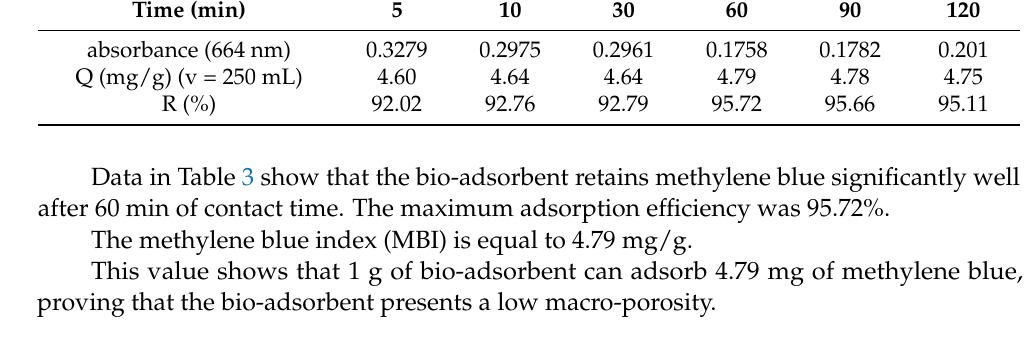
pzc ) for raw ALP bio-sorbent.